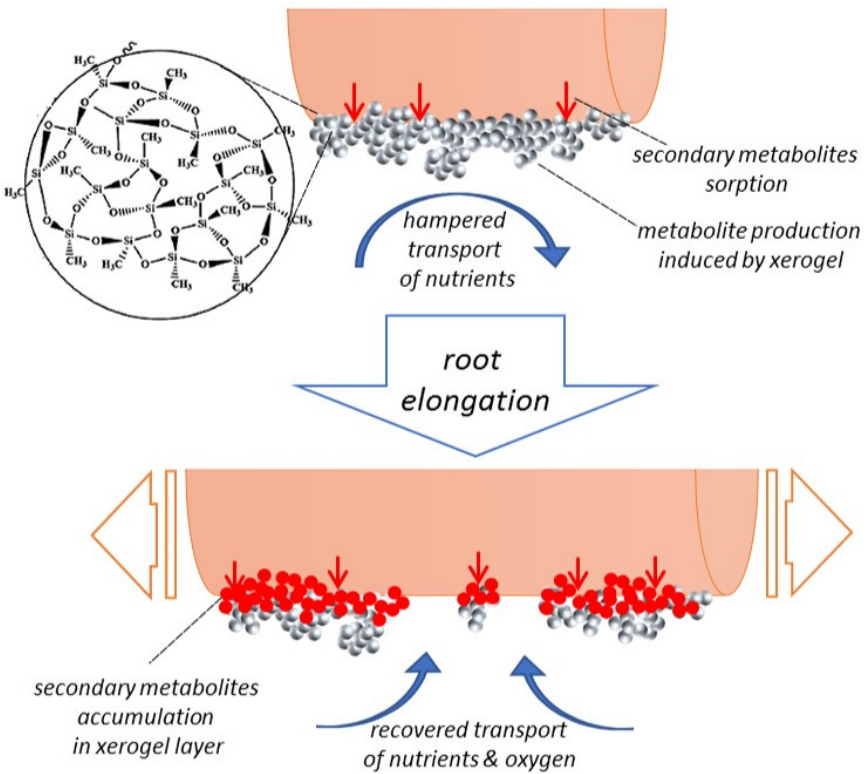
Figure 12. Schematic diagram showing the hypothetical effects of xerogel on the growth and production of metabolites in transgenic roots at different culture stages.